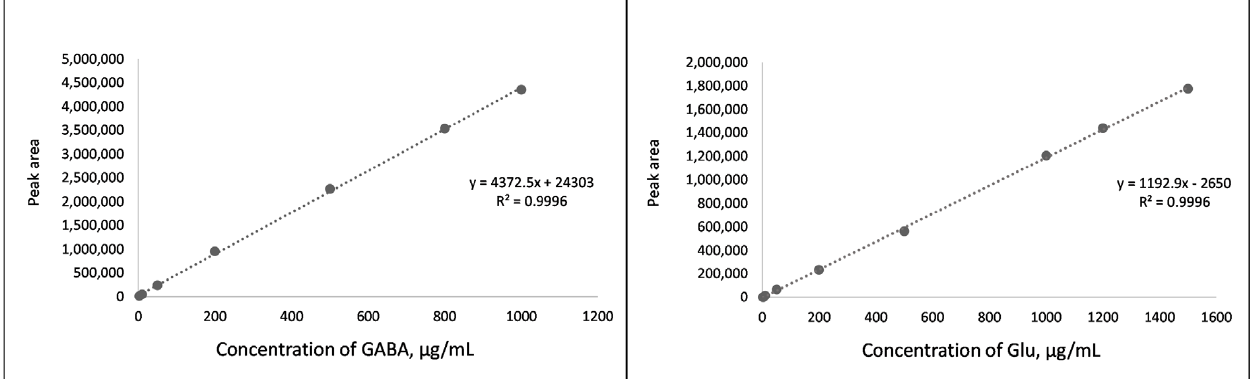
Figure 1. Standard curves for GABA and Glu.